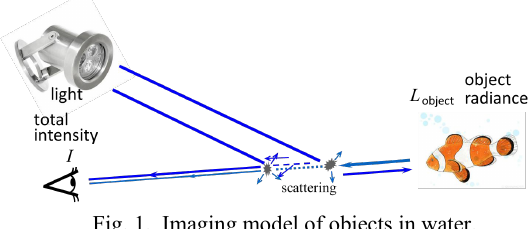
Fig. 1. Imaging model of objects in